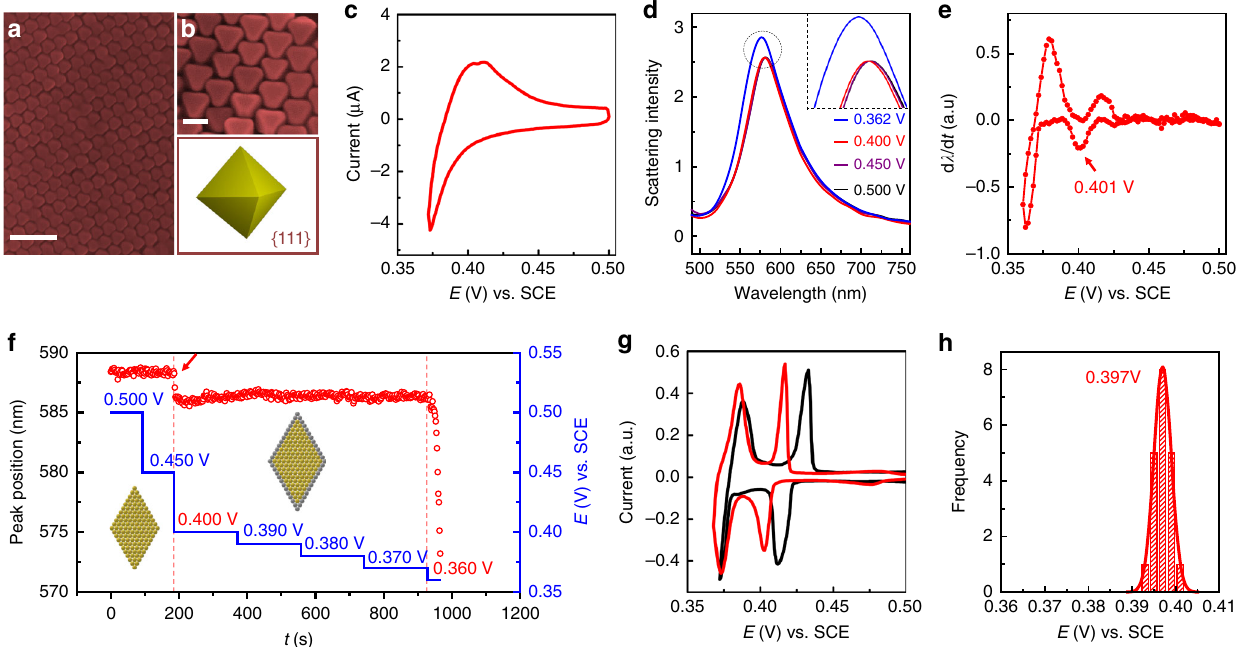
Fig. 2 Study of Ag electrodeposit on the octahedral Au nanocrystals surface. SEM images of a large and b (top) small scale along with b (bottom) structural schematic of Au nanooctahedrons to show their highly ordered geometry on the electrode surface and the structural details. c A cyclic voltammogram (CV) of Ag underpotential deposition (UPD) on a Au nanooctahedrons-coated glassy carbon electrode in the electrolyte of 1 mM Ag 2 SO 4 and 0.05 M H 2 SO 4 . d The potential-dependent scattering spectra of a single Au nanooctahedron. The inset is the zoom-in spectra showing the details of spectral variation. e The optical “ CV ” of a single Au nanooctahedron reconstructed using the peak position of the scattering spectra as a function of the applied potential. f The time-dependent peak position change of the scattering spectra of a single Au nanooctahedron under different potential controls (from 0.500 to 0.400V with a step of 50 mV and from 0.400 to 0.360 V with a step of 10 mV). g CVs for the Ag deposition on a Au (111) electrode before (black curve) and after (red curve) the adsorption of the surfactant, CTAB. h The peak potential statistics of UPD peaks obtained from the optical “ CV ” s of 20 individual Au nanooctahedrons. The scale bars are 200 nm in a and 50 nm in b